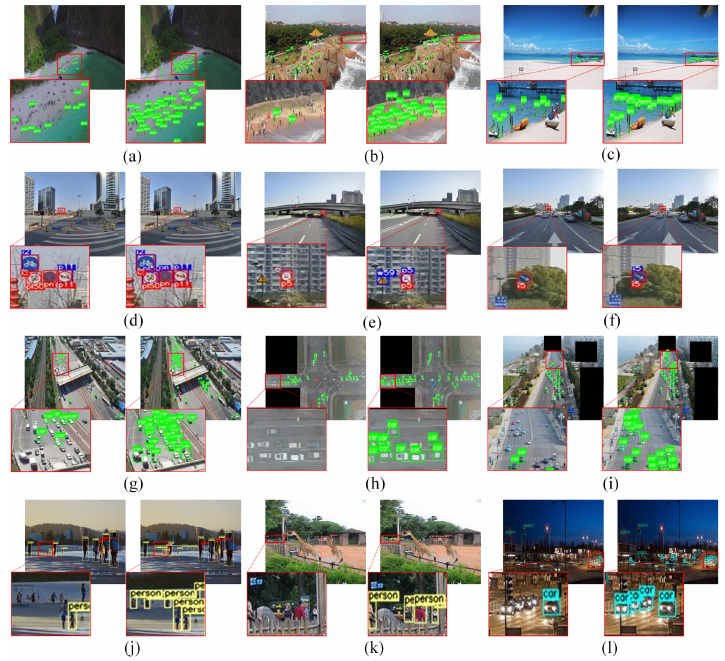
Figure 6. Sample testing results of TinyPerson (shown in subfigures ( a – c )), Tsinghua-Tencent 100K (shown in subfigures ( d – f )), UAVDT (shown in subfigures ( g – i )) and MS COCO (shown in subfigures ( j – l )) test